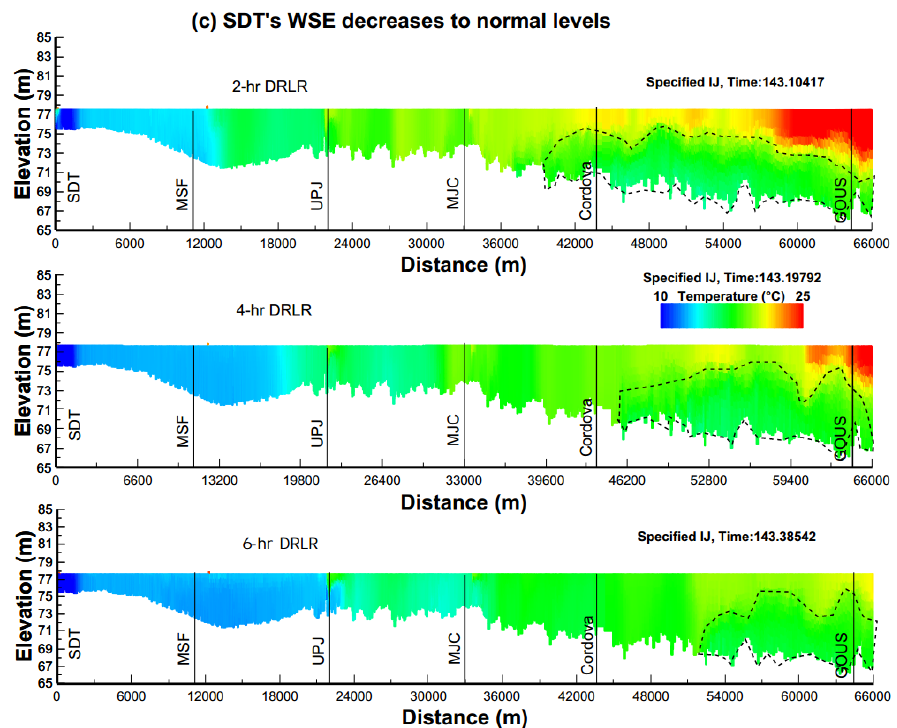
Figure 7. Simulated water temperature distributions for 2-h, 4-h and 6-h DRLRs at three different times: ( a ) just before the large release; ( b ) after the large release has just stopped; and ( c ) when SDT’s WSE decreases to normal levels.